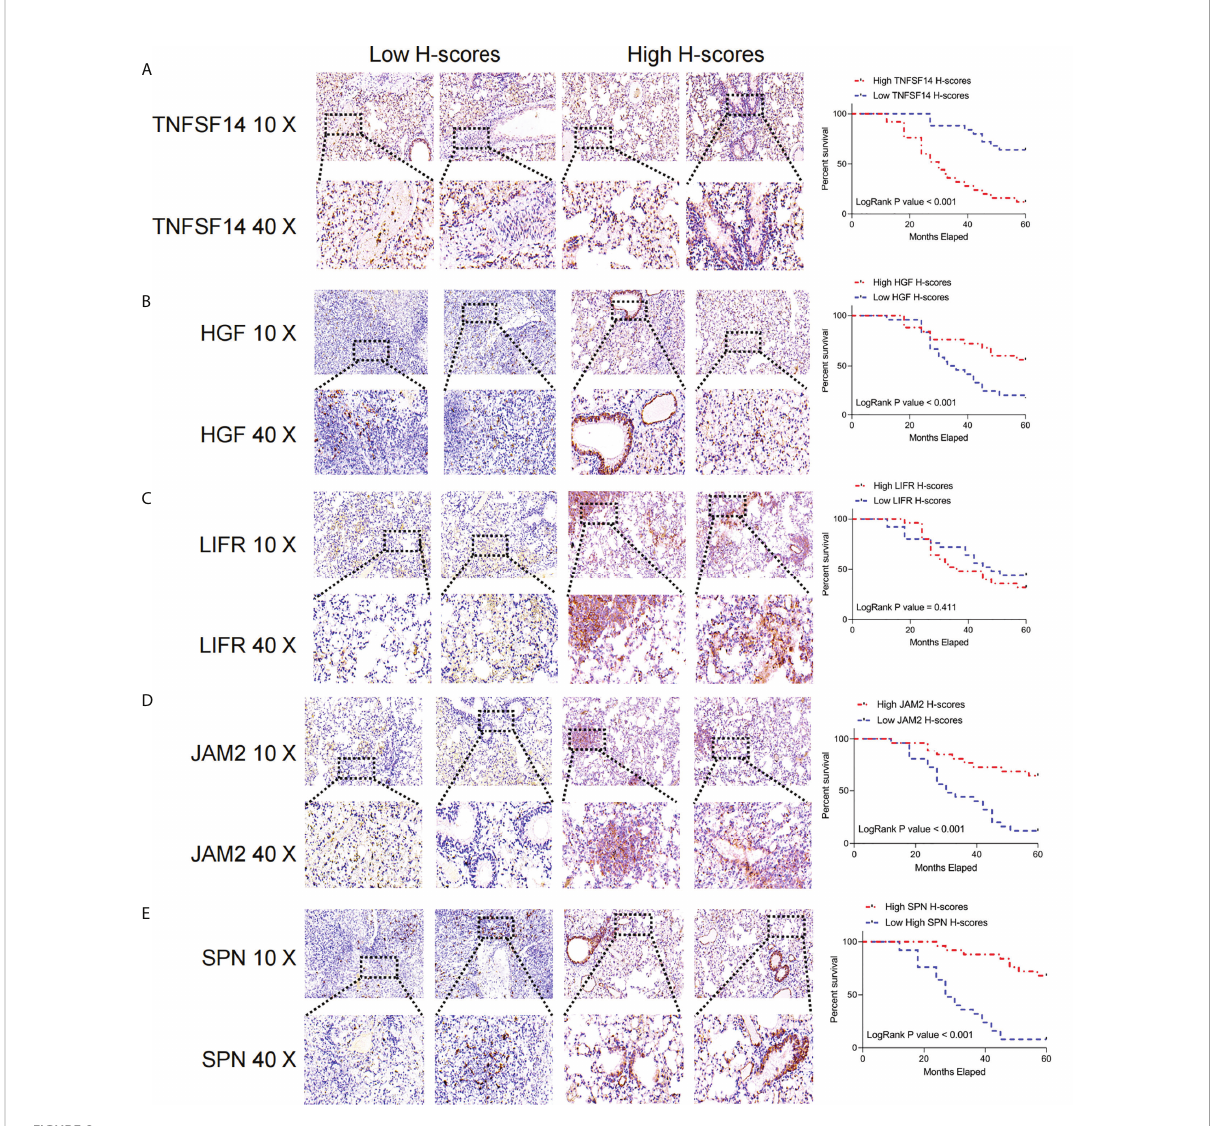
FIGURE 9 Immunohistochemical analysis of the key FRGs in the FRS model. High TNFSF14 expression, low JAM2, HGF, and SPN expression were associated with poor prognosis in patients with LUAD. (A) Immunohistochemical analysis of the intensity of TNFSF14 staining in tumors from 50 patients with lung adenocarcinoma and Kaplan-Meier analysis of the correlation between H-scores of immunohistochemistry for TNFSF14 and the survival cycle of patients with LUAD; (B) Immunohistochemical analysis of the intensity of HGF staining in tumors from 50 patients with lung adenocarcinoma and Kaplan-Meier analysis of the correlation between H-scores of immunohistochemistry for HGF and the survival cycle of patients with LUAD. (C) Immunohistochemical analysis of LFR staining intensity in tumors from 50 lung adenocarcinoma patients, Kaplan-Meier analysis of H-scores of immunohistochemistry for LFR correlated with the survival cycle of LUAD patients; (D) Immunohistochemical analysis of JAM2 staining intensity in tumors from 50 lung adenocarcinoma patients, Kaplan-Meier analysis of JAM2 H-scores of immunohistochemistry correlated with the survival cycle of LUAD patients; (E) immunohistochemistry analyzed the intensity of SPN staining in the tumors of 50 lung adenocarcinoma patients, and Kaplan-Meier analyzed the correlation of H-scores of immunohistochemistry of SPN with the survival cycle of LUAD